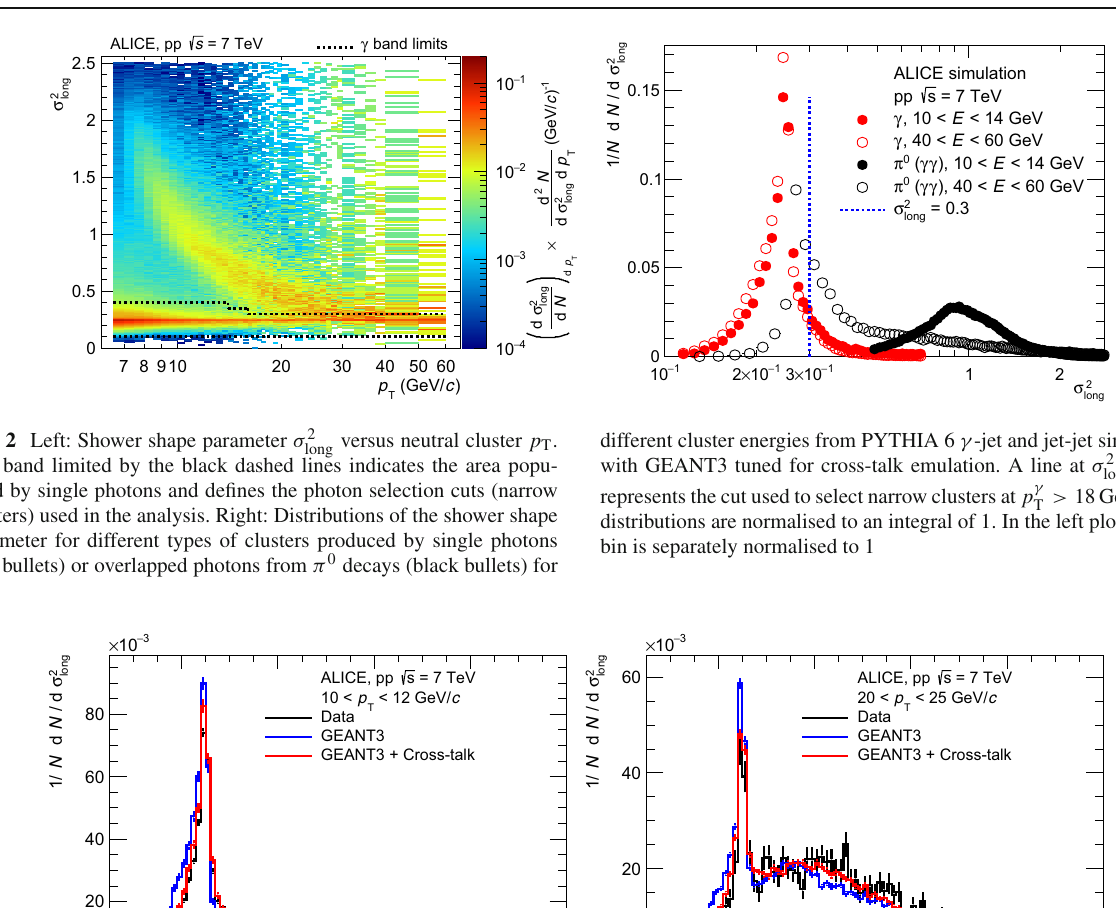
of neutral lations,PYTHIA6jet-jet + γ -jetevents,withGEANT3defaultsettings long in blue. The red histograms are also simulations based on GEANT3, but tuned to reproduce the cross-talk observed in the EMCal